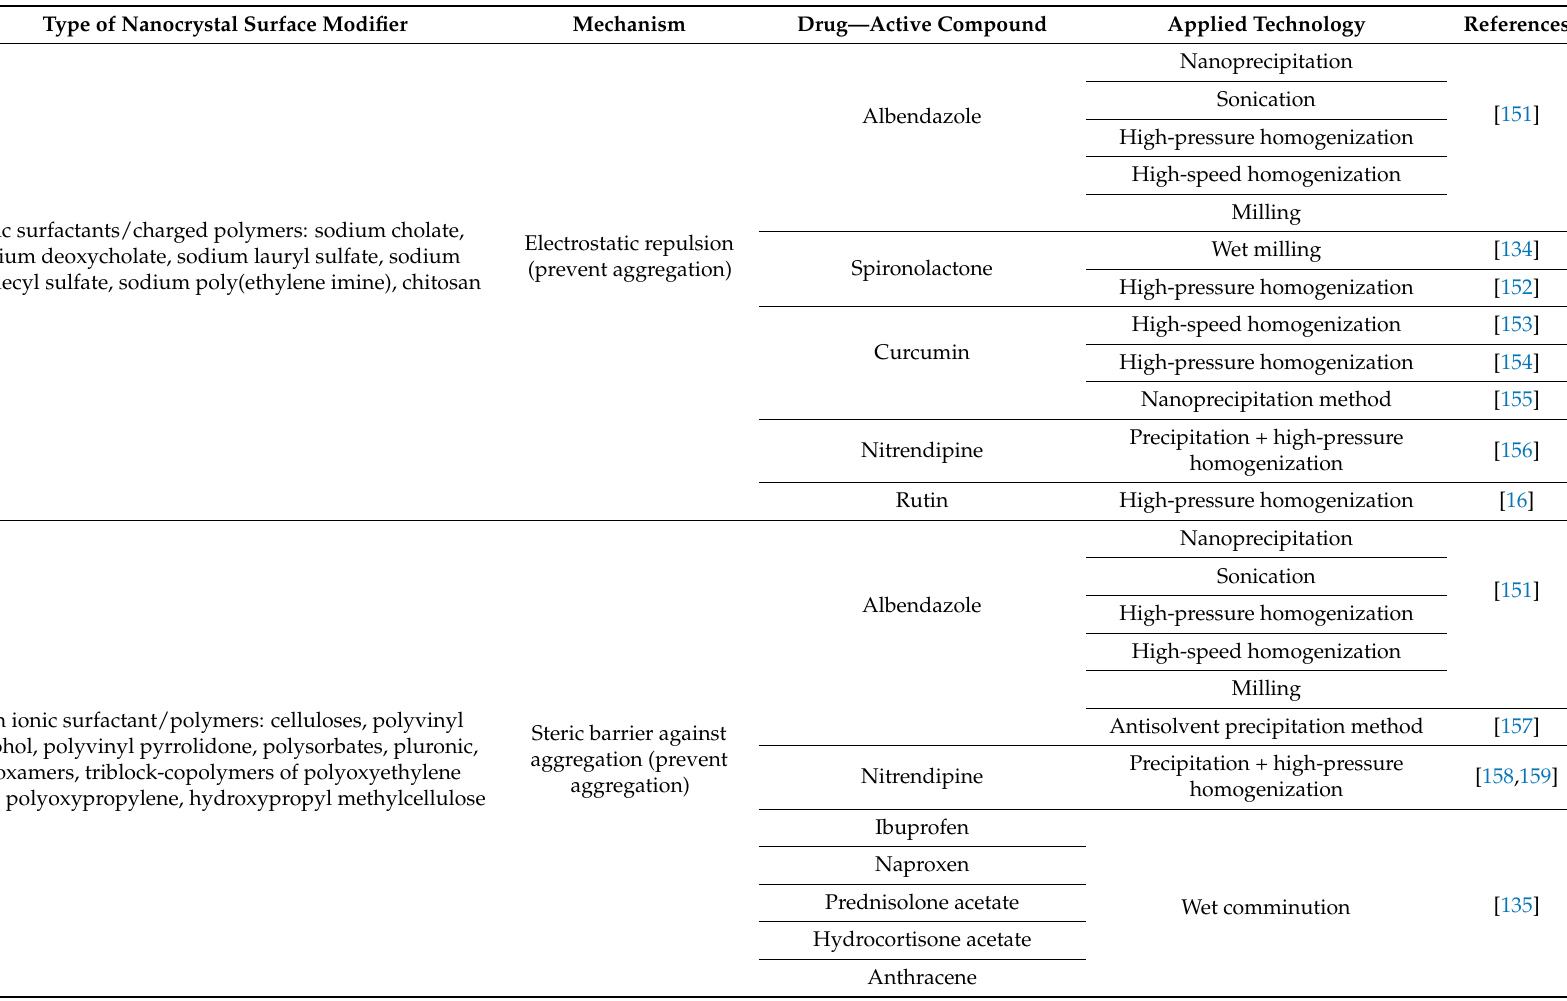
Table 3. Stabilization and functionalization of nanocrystals (nanosuspensions) by means of different stabilizers and surface